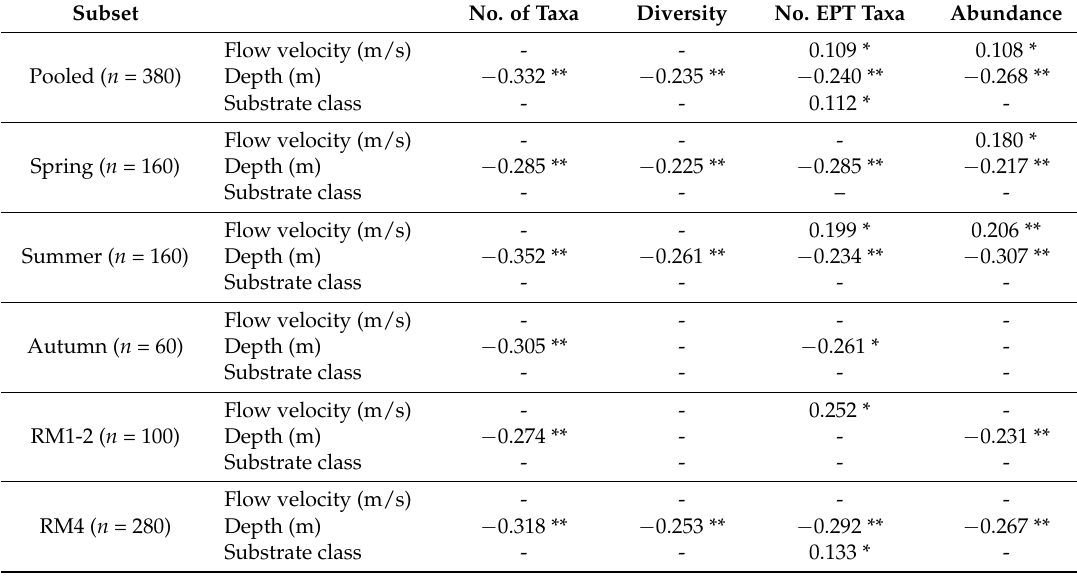
Table A1. Statistically significant correlations (Spearman’s coefficient) between the three hydrological-hydraulic variables and the four benthic-invertebrate metrics used to calculate the microhabitat suitability.